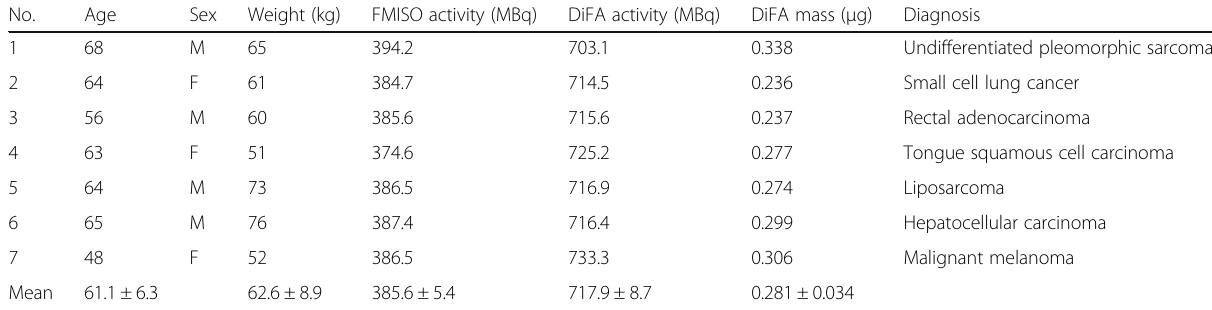
Table 2 Characteristics of the seven patients with malignant tumors No.